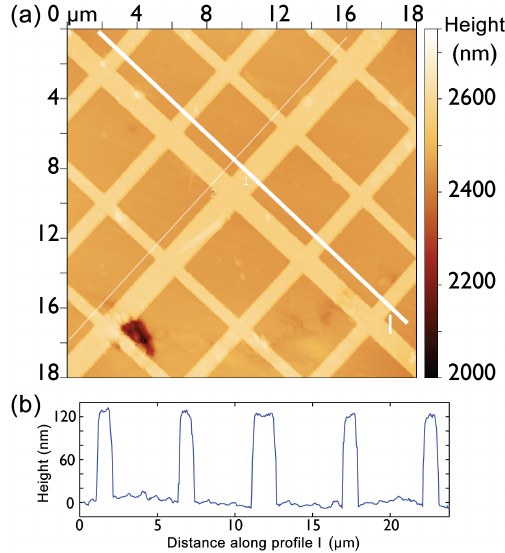
Figure 5. Atomic force micrographs of patterned San Carlos olivine (a) and the height profile (b) of the surface along profile 1. The 500nm wide chromium lines are spaced every 4.5µm and are 110nm high. The sharpness of the lines can be appreciated in the AFM